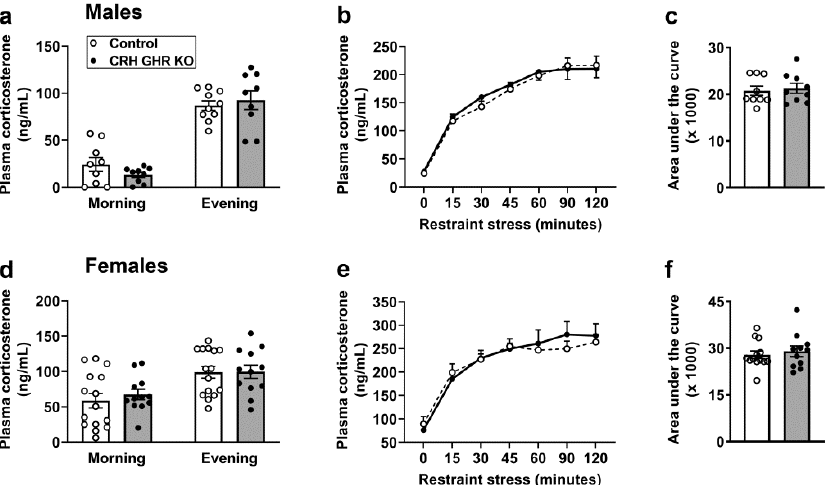
Figure 5. GHR ablation in CRH cells does not affect circadian or restraint-stress-induced corti- costerone secretion. ( a ) Plasma corticosterone levels in the morning (09:00 a.m.; lights on at 08:00 a.m.) and in the evening (19:00) in control ( n = 9–10) and CRH GHR KO ( n = 9) male mice. ( b , c ) Changes in plasma corticosterone levels during restraint stress in control ( n = 9) and CRH GHR KO ( n = 9) male mice. ( d ) Plasma corticosterone levels in the morning and in the evening in control ( n = 15) and CRH GHR KO ( n = 12) female mice. ( e , f ) Changes in plasma corticosterone levels during restraint stress in control ( n = 13) and CRH GHR KO ( n = 11) female mice.